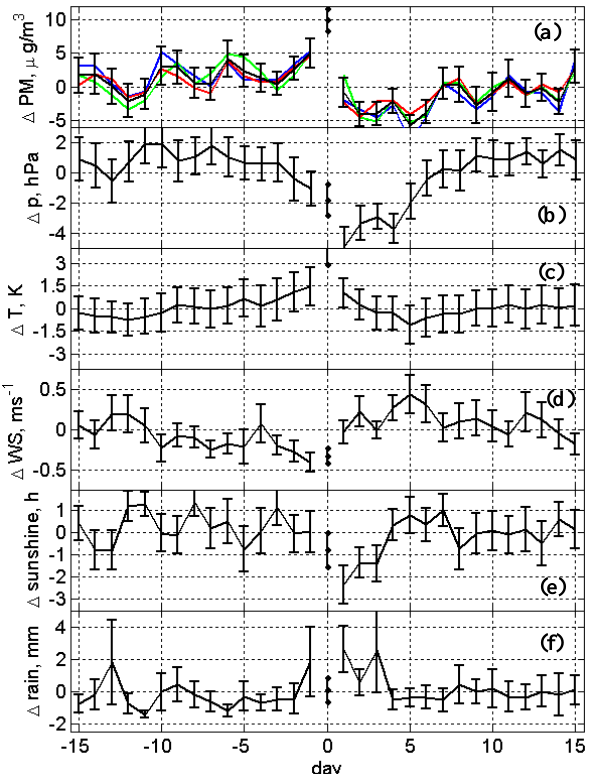
Fig. 1. Average daily variation of PM 10 and meteorological param- eters with respect to their average in the 15day time span preceding Figure 1 Average daily variation of PM 10 and meteorological parameters with respect to 678 and following all the dust advections encountered in the 4yr study. their average in the 15-day time span preceding and following all the dust advections 679 Error bars represent the 95% confidence intervals of such averages. The average values during the whole Saharan event (whatever its encountered in the 4-year study. Error bars represent the 95% confidence intervals of such 680 length) are reported at time zero. PM 10 curves (a) are reported for averages. The average values during the whole Saharan event (whatever its length) is 681 MG (blue), VA (green), FC (red) and for the ensemble of the three reported at time zero. PM 10 curves (a) are reported for MG (blue), VA (green), FC (red) and 682 stations (black). Meteorological parameters considered are: pres- sure (b) , temperature (c) , wind speed (d) , sunshine (e) and rainfall for the ensemble of the three stations (black). Meteorological parameters are: pressure (b), 683 (f) , temperature (c), wind speed (d), sunshine (e) and rainfall (f), respectively. 684